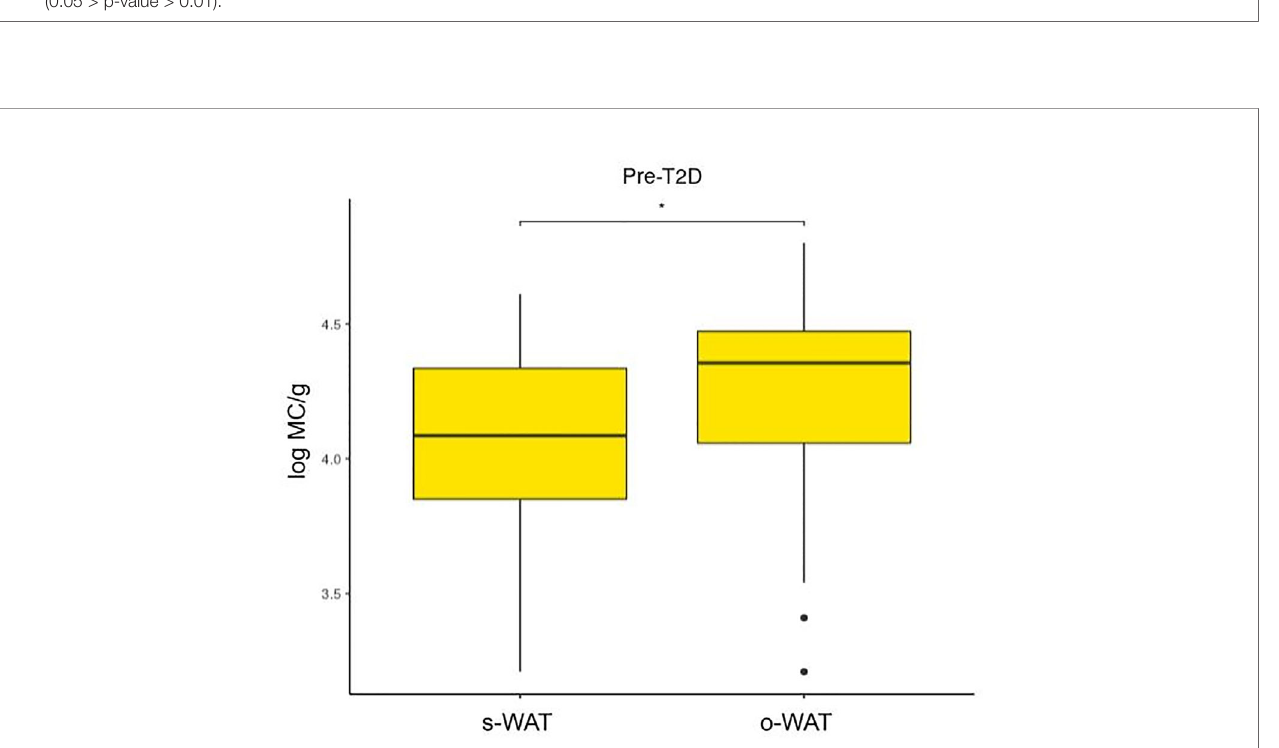
FIGURE 5 | Differences in mast cells per gram of tissue between subcutaneous and omental white adipose tissue in patients with pre-type 2 diabetes. The data comes from the big cohort (n = 100). MC (mast cells), s-WAT (subcutaneous white adipose tissue), o-WAT (omental white adipose tissue), T2D (type 2 diabetes), “ * ” (0.05 > p-value > 0.01).